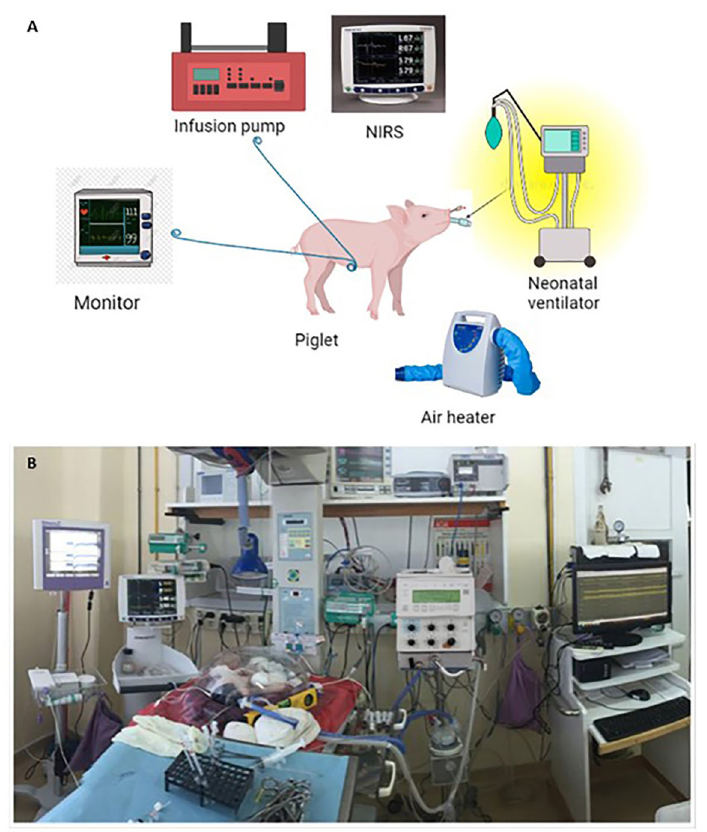
Figure 2. Experimental set-up. A , Main equipment used in the experiments; B , Photograph of the experimental laboratory. NIRS: near- infrared spectroscopy.